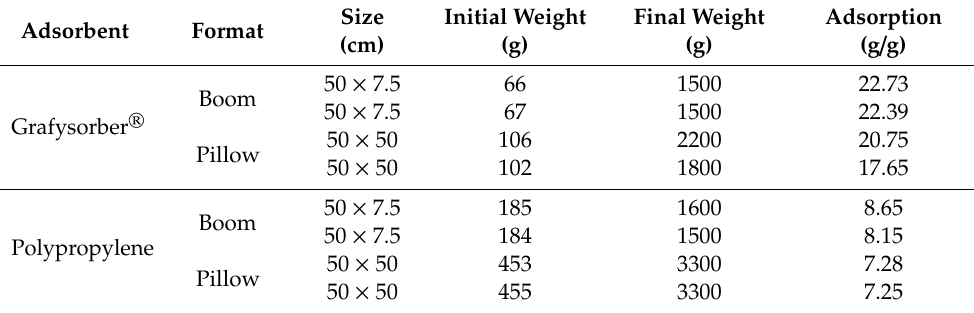
Table 2. Samples for tank